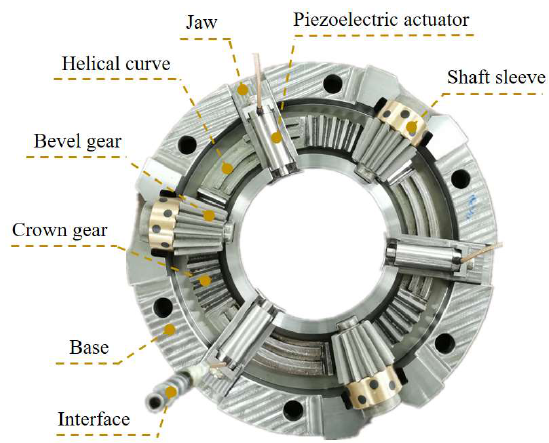
Figure 4. Internal diagram of self-aligning flange.